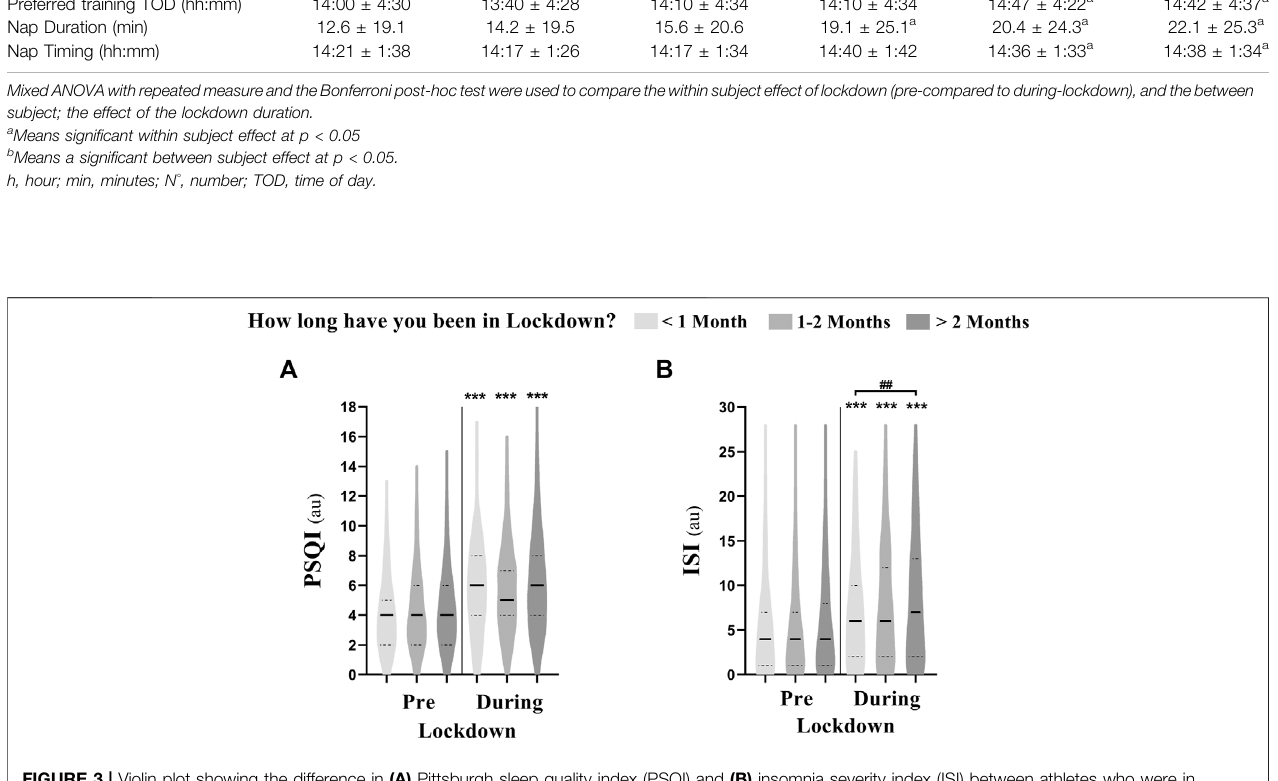
Frontiers in Physiology |